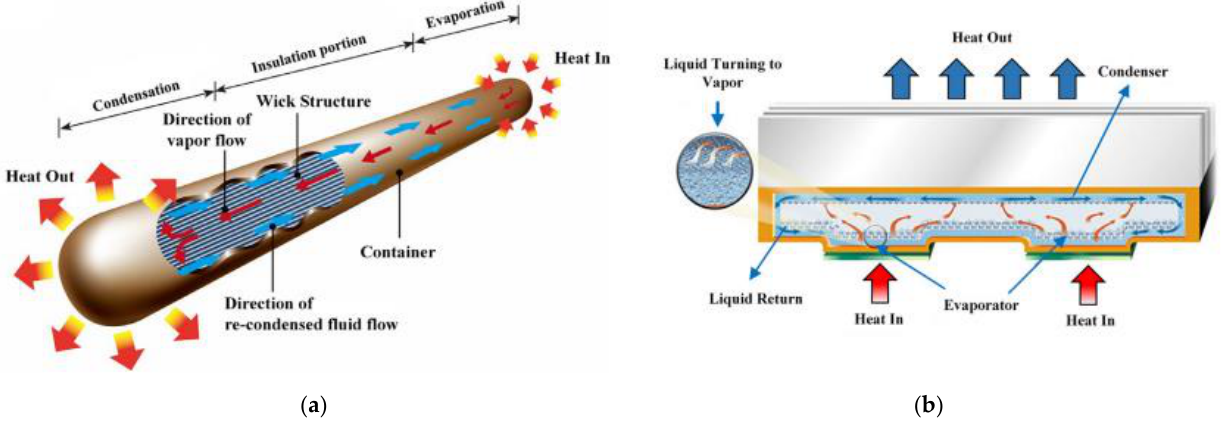
Figure 24. ( a ) Working principle of a standard tubular heat pipe. ( b ) 2D schematic diagram of a standard heat pipe. Reprinted with permission from [195] . Copyright 2008 Elsevier.